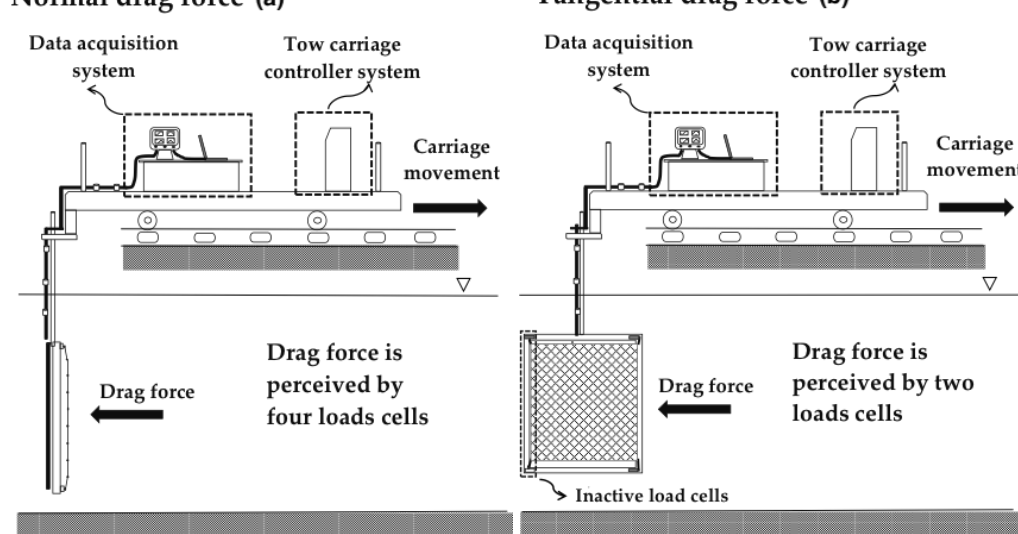
Figure 2. Lateral view of the experimental facility to measure the ( a ) normal drag force and ( b ) tangential drag force. The normal drag force was recorded by four load cells located in the corners of the frame. The tangential drag force was recorded by two load cells located in the front corners of the frame. The experiments performed considered two case studies: (i) determination of the normal drag force of the net and (ii) determination of the drag force tangential to the net. In the first case, the